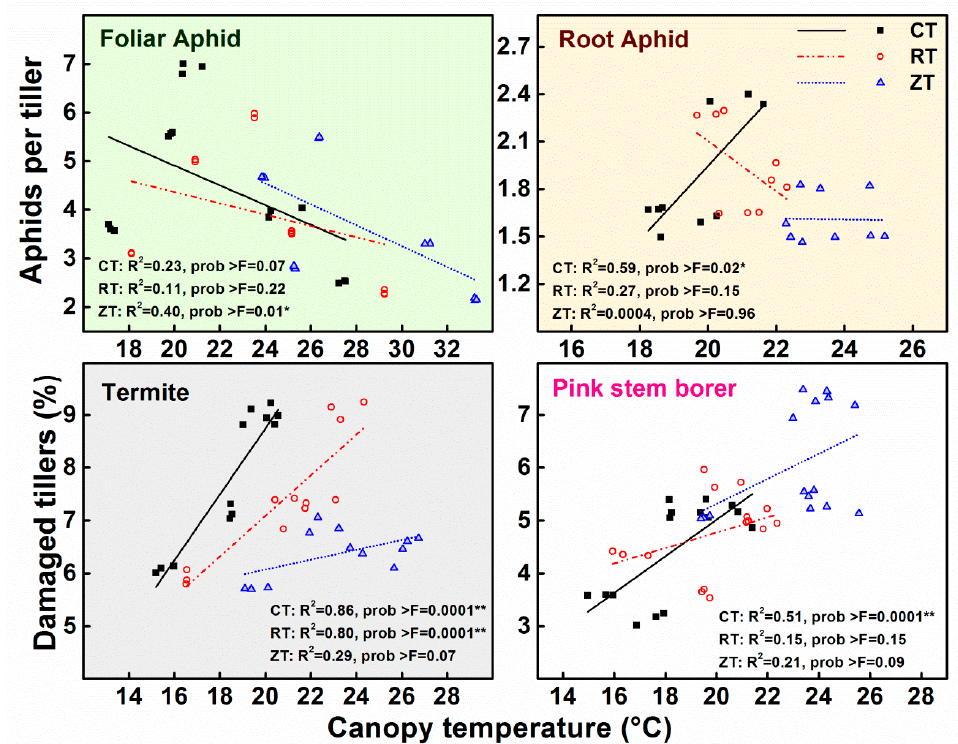
Figure 9. Correlation between canopy temperature ( ◦ C) and aphid abundance (aphids/tiller) or damage (%) in wheat grown under 3 tillage practices during 2016–2017 and 2017–2018 (pooled). (‘*’— p < 0.05; ‘**’— p < 0.01).